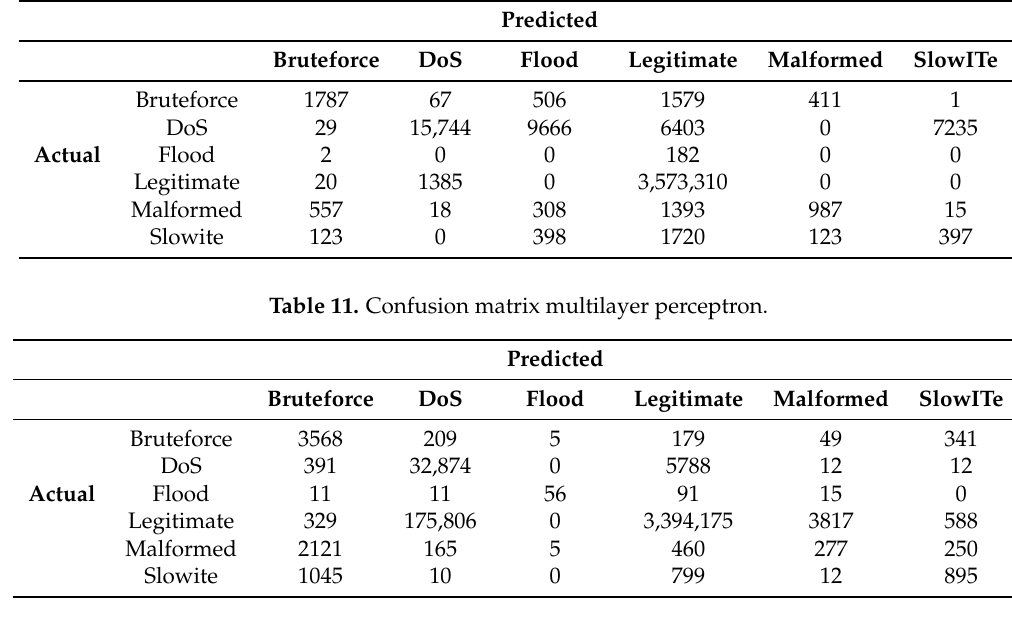
Table 10. Confusion matrix gradient boost.